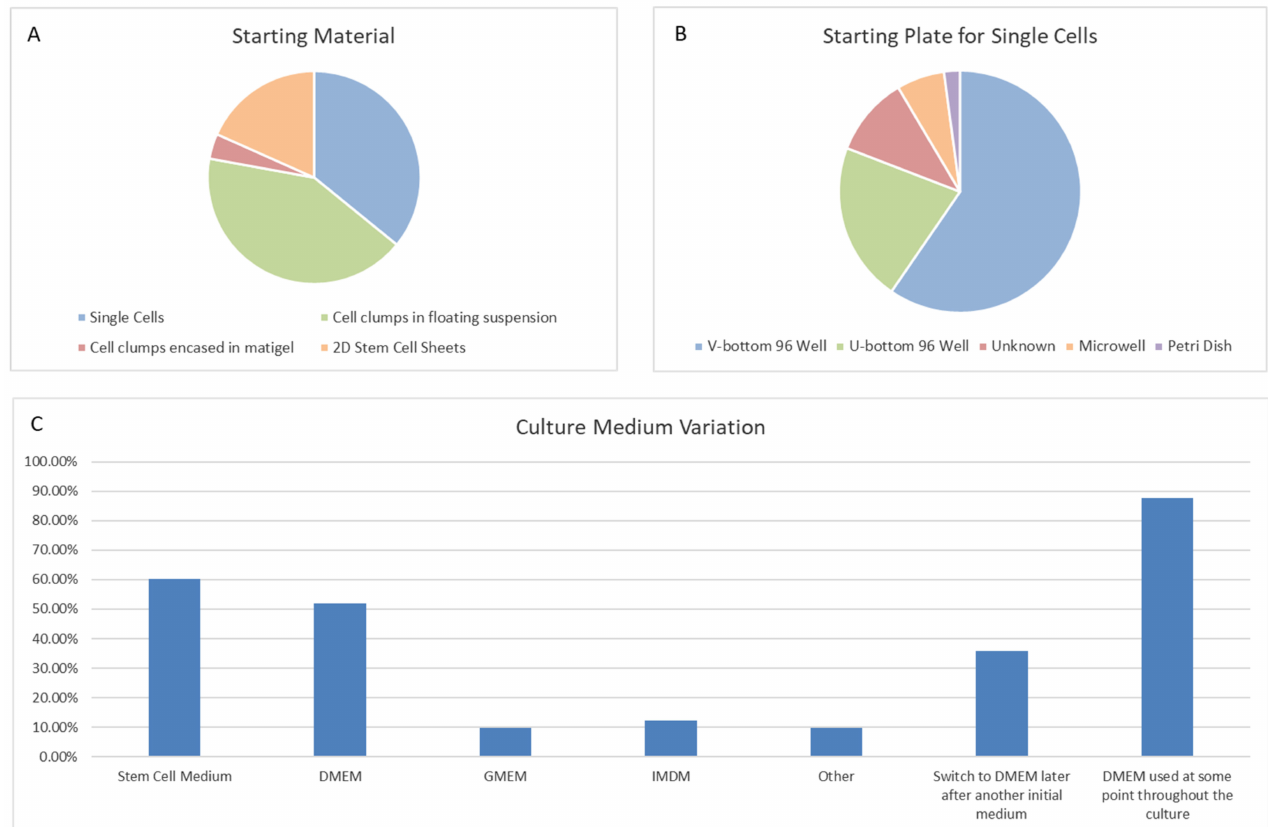
Figure 8. A breakdown of organoid techniques used. ( A ) Analysis of organoid protocols revealed that the most popular method of generating retinal organoids was starting with stem cell clumps in suspension, followed closely by single-cell aggregation. ( B ) For single-cell aggregation starts, the majority of methods used 96-well plates, with V-bottom plates being the most popular. ( C ) Different protocols use a variety of different media to start their differentiations, either alone or in combination. We found that starting with stem cell medium and/or DMEM was the most popular choice. Interestingly, although other protocols did start with other media such as GMEM or IMDM, we found that for long-term culturing, they switched to DMEM, meaning the overall number of protocols that use DMEM at some point in the differentiation is extremely